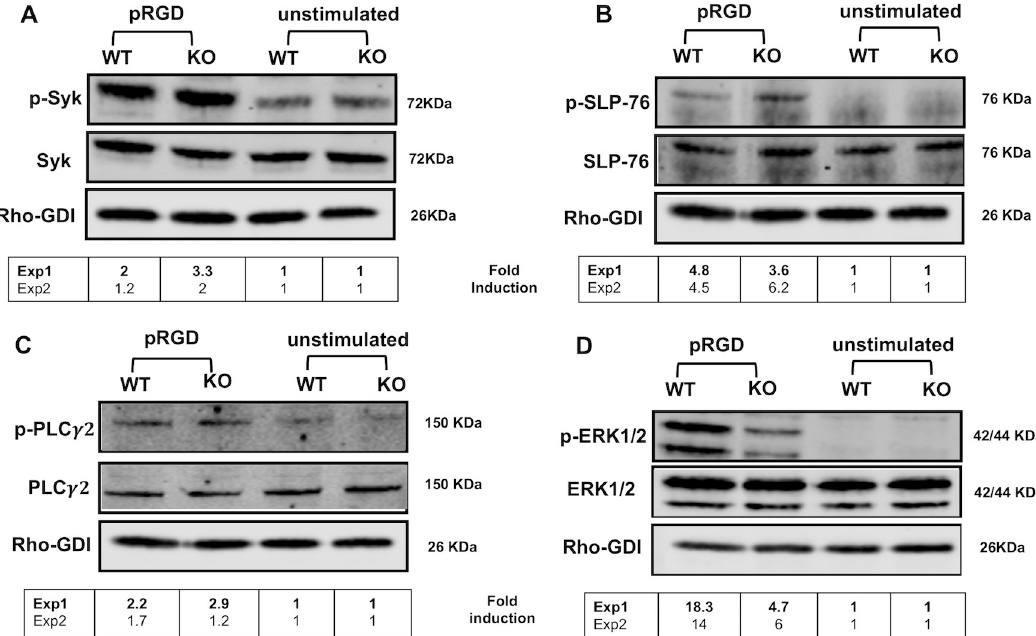
Fig 5. SKAP2 affects ERK1/2 signaling downstream of integrin receptor stimulation in neutrophils. WT and Skap2KO BM neutrophils were unstimulated on a FBS coated surface or stimulated on poly-RGD coated surface for 10 min, and lysates were immunoblotted with (A) anti-Syk pY352, striped and then reprobed with anti-Syk, (B) anti-SLP-76 pY128, striped and then re- probed with anti-SLP-76, (C) anti-PLC γ 2 pY1217, striped, and then reprobed with anti- PLC γ 2, or (D) anti-ERK1/2 (pThr202/ pTyr204) striped and reprobed with anti-ERK1/2. Anti-Rho-GDI was used as a loading control for all blots. Fold induction was calculated by dividing the normalized phospho-tyrosine signal by the unstimulated control of each genotype. Blots shown are a representative of 2 independent experiments. Fold induction values from each experiment is shown in the lower panel with blots from experiment 1 (Exp1) presented.